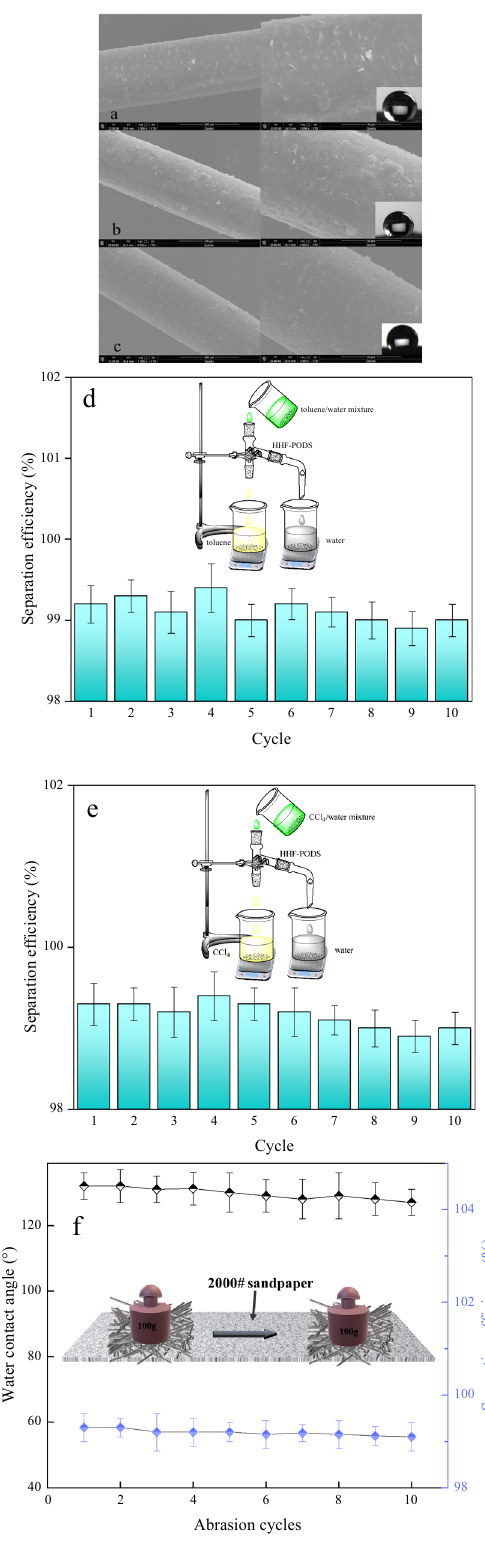
Figure 6. After immersion in pH 2, 7 (3.5 wt% NaCl solution) and 10 for 4 h, the morphology of HHF-PODS was almost unchanged, and a dense coating of PODS on the HHF-PODS surface was preserved, while intact fibrosis also verified the excellent resistance. ( a–c ) Reusability experiments of HHF-PODS for separating oil/ water mixtures. The light oil (toluene)/water mixture was separated 10 times ( d ). The heavy oil (CCl 4 )/water mixture was separated 10 times ( e ), with an oil/water mixture separation efficiency higher than 99.0%. The WCA of HHF-PODS and separation ability after the 10 successive reusability tests with sand paper ( f